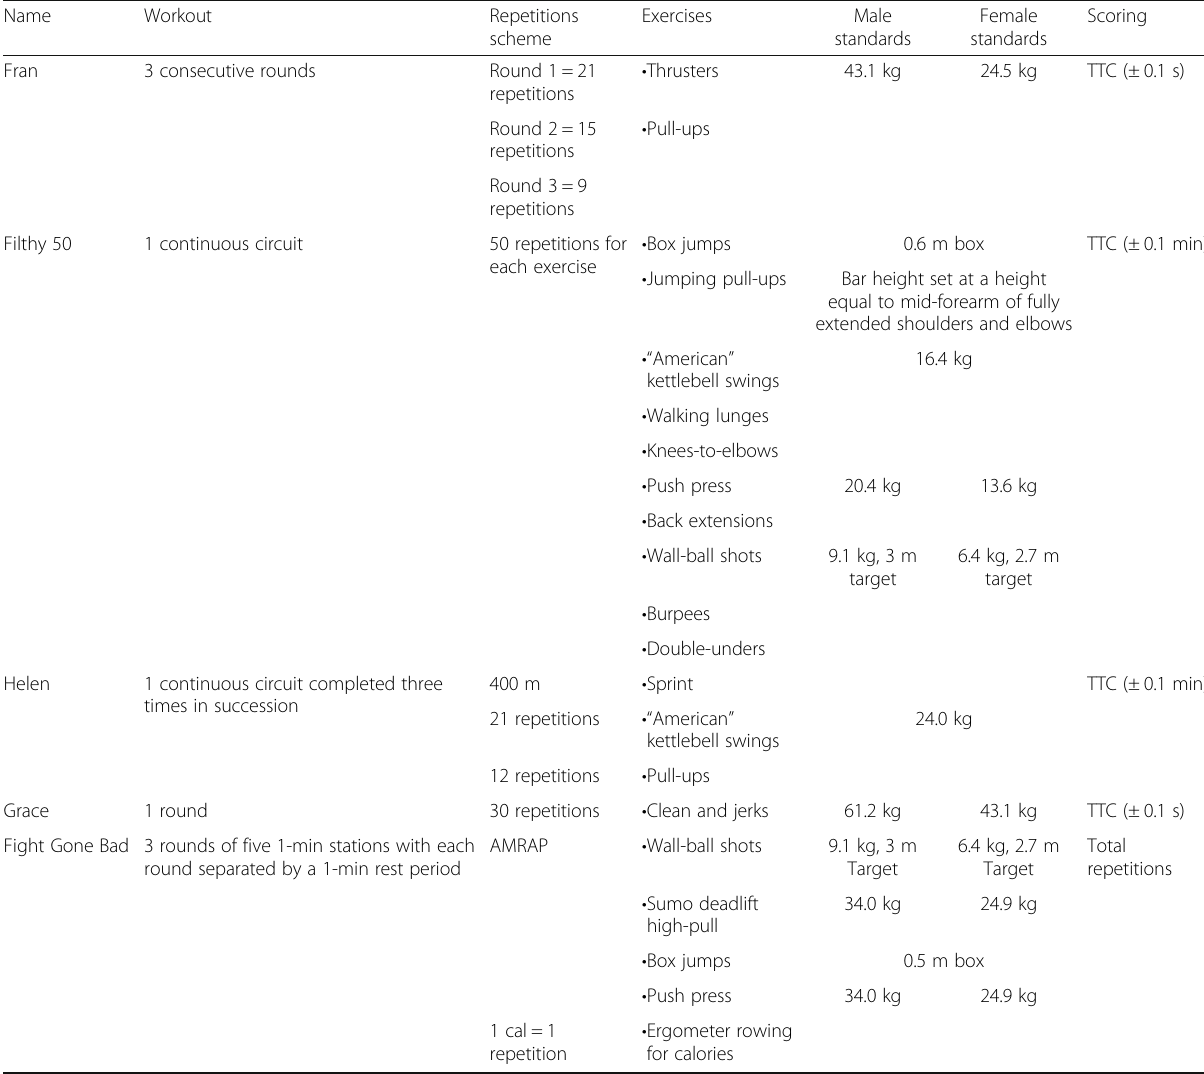
Table 1 Description of standards for five common benchmark